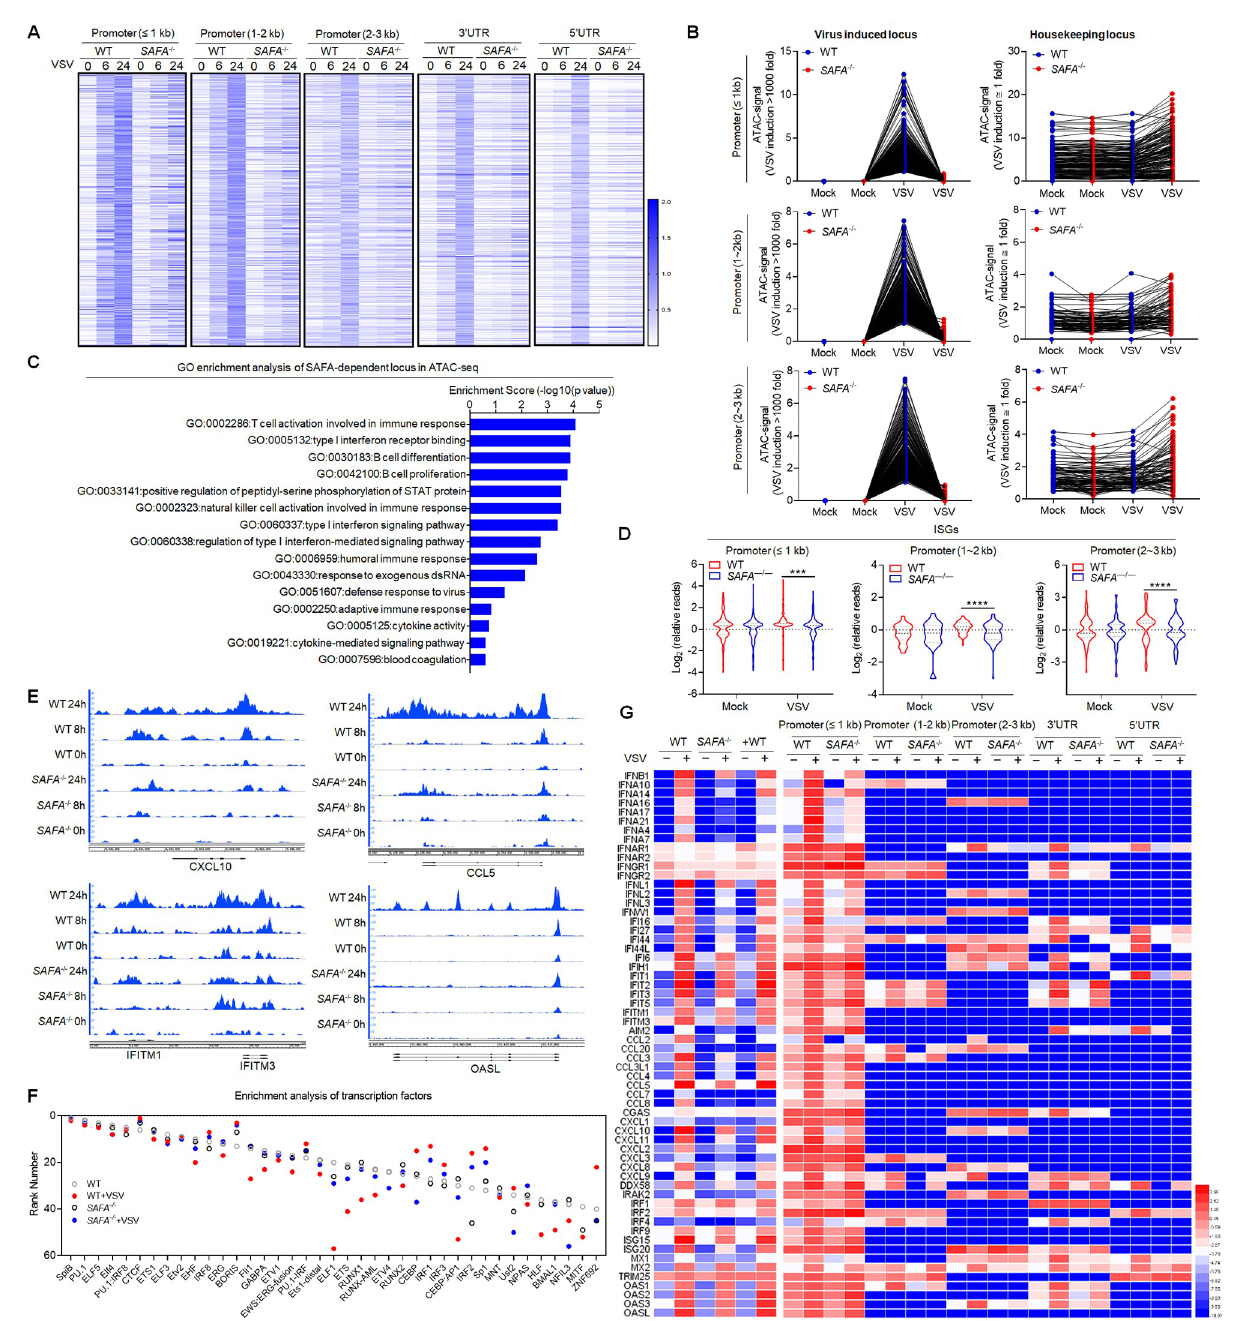
Fig 1. SAFA deficiency decreased the chromatin accessibility of antiviral immune genes. (A) Heatmap (log RPKM+1) showing the ATAC-seq signal in Wild-type (WT) and SAFA − / − THP-1 cells with VSV infection for indicated hours. (B) Line graph (RPKM) showing SAFA in regulation of VSV- induced accessible locus and housekeeping locus in ATAC-seq. (C) GO term enrichment analysis of genes significantly affected by SAFA depletion in ATAC-seq. (D) Violin graph (log RPKM) showing ISGs affected by SAFA depletion in ATAC-seq. (E) Genome browser views of ATAC-seq signal for the indicated genes. (F) Transcription factor enrichment analysis of ATAC-seq. (G) Heatmap comparing ATAC-seq signal (log RPKM+1) and RNA- seq signal (log FPKM+1) of indicated genes. ��� p < 0.001, ���� p < 0.0001 (Student’s t test; D). The cells were infected by VSV at 0.1 multiplicity of infection (MOI). Data were pooled from two independent experiments (A-D, F and G). Data were representative of two independent experiments (E).